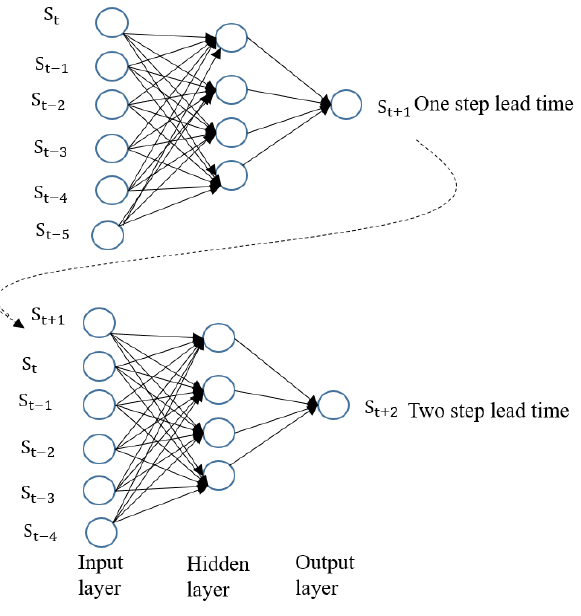
Figure 10. An example of a recursive